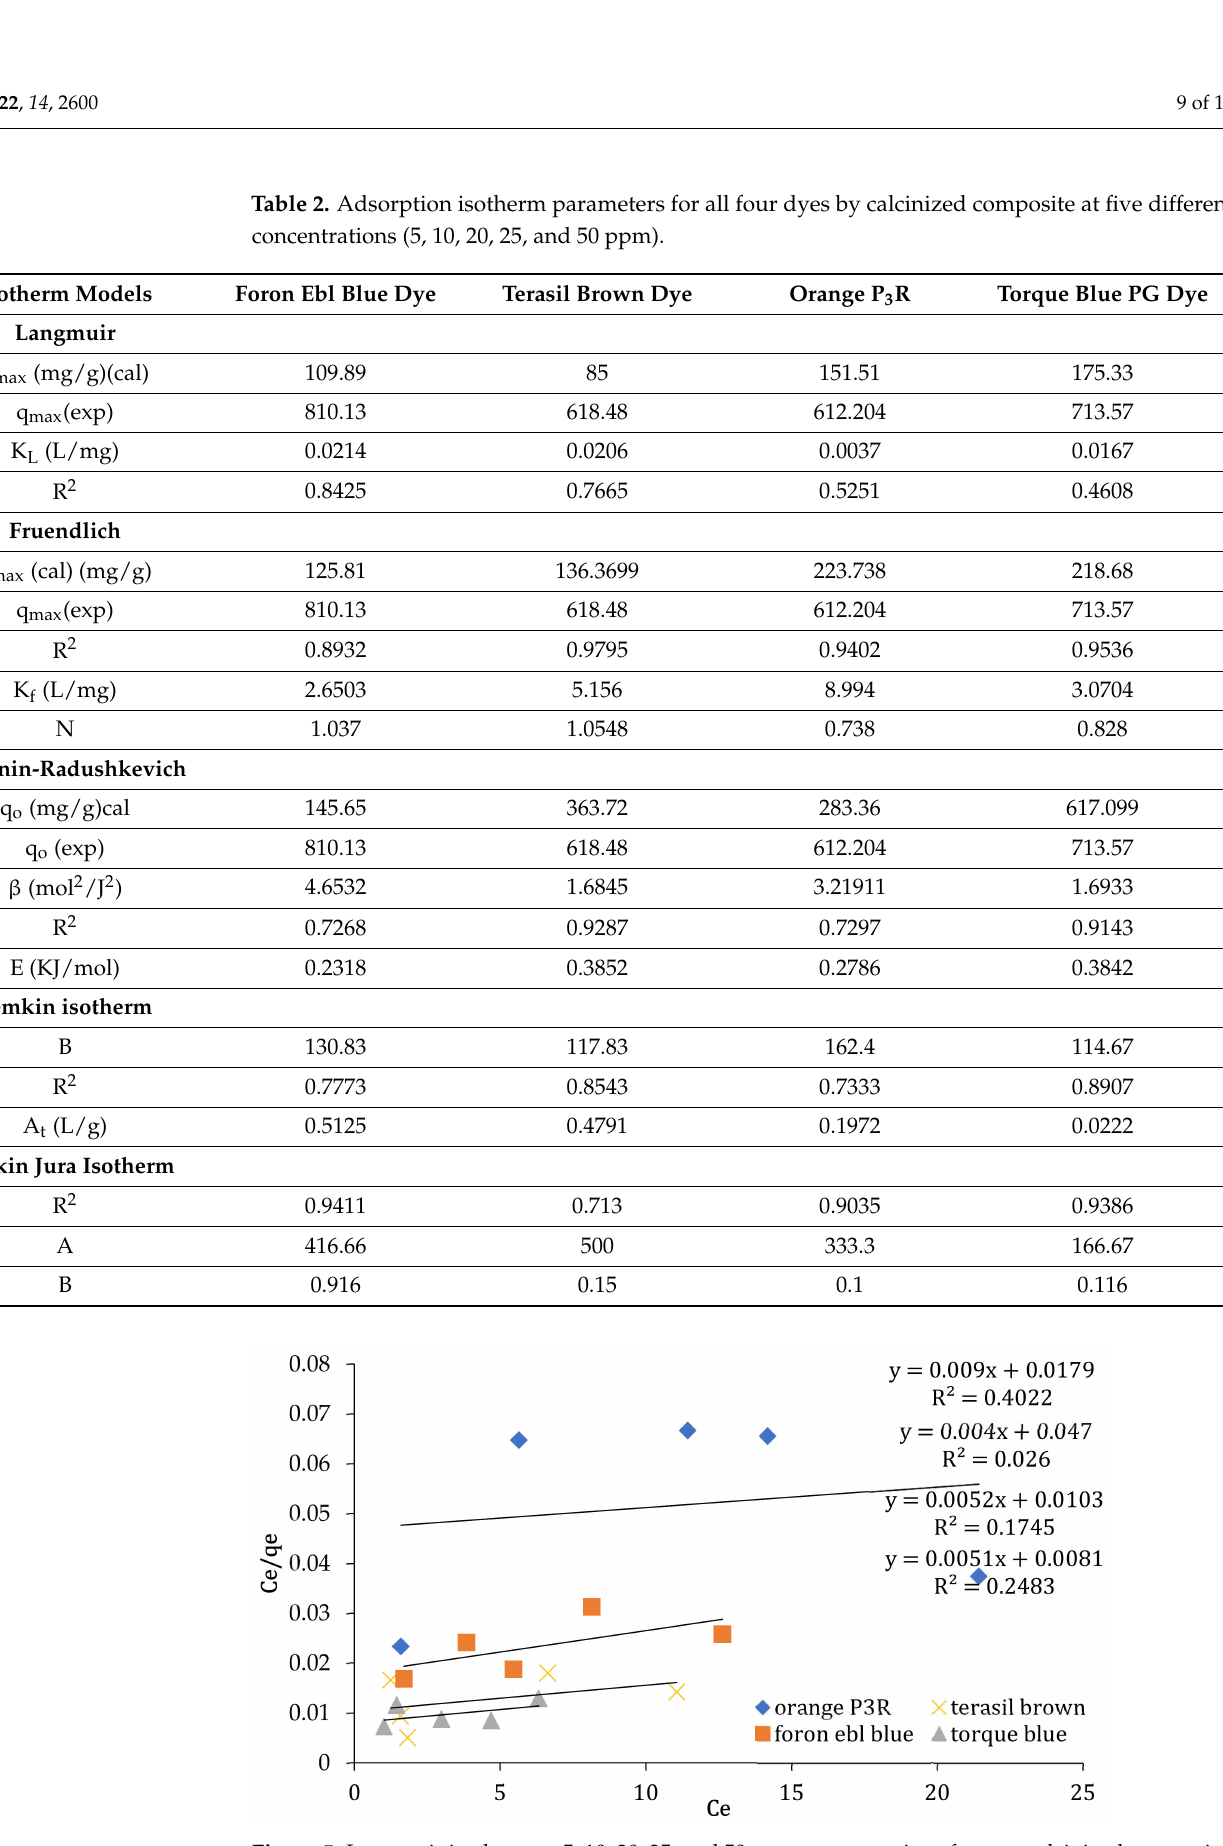
Figure 5. Langmuir isotherm at 5, 10, 20, 25, and 50 ppm concentrations for non-calcinized